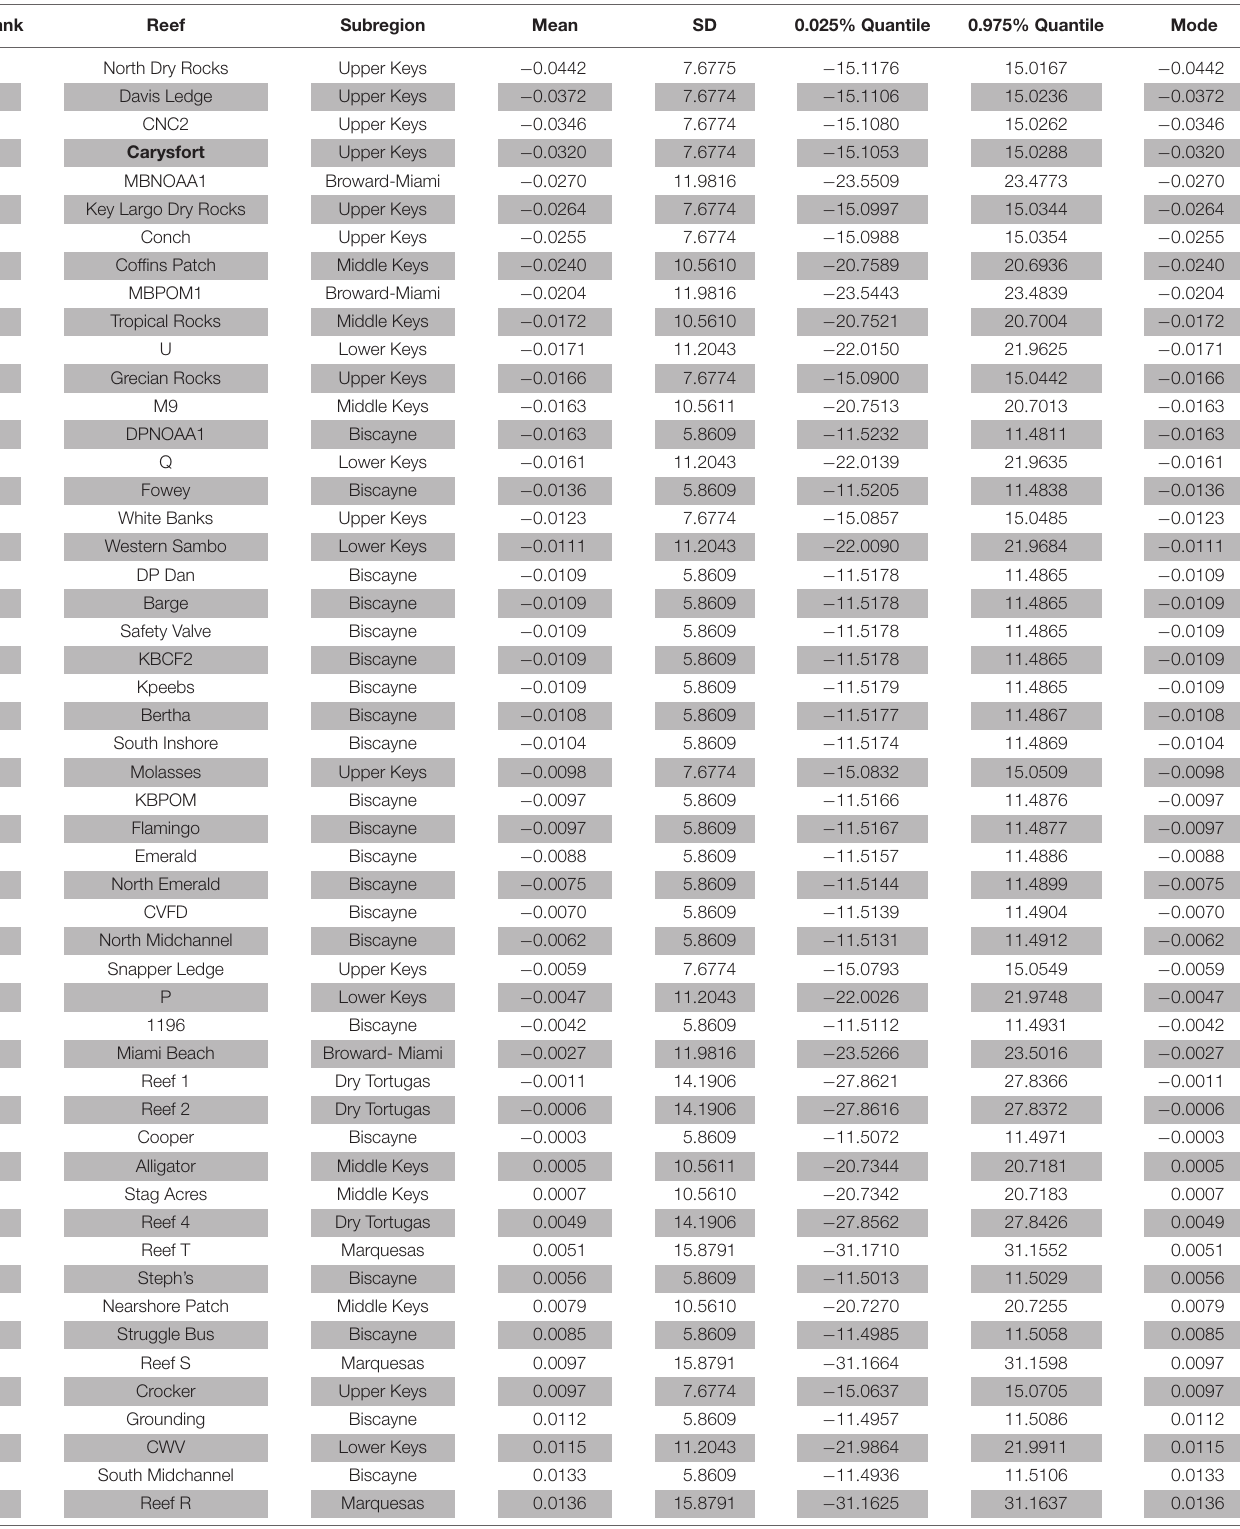
TABLE 1 | Posteriori mean (Mean); standard deviation (SD); 0.025, and 0.975% Quantile values; and Mode of the posteriori mean values using 67 reefs as the fixed effect in the Integrated Nested Laplace Approximation (INLA) model for 22,634 Acropora cervicornis outplants in 7 subregions along the Florida reef tract, United States from 2012 to 2018. The 7 subregions (from north east to south west) include: 1) Broward-Miami, 2) Biscayne, 3) Upper Keys, 4) Middle Keys, 5) Lower Keys, 6) Marquesas, and 7) Dry Tortugas. The reefs are listed from highest to lowest likelihood of survival of A. cervicornis outplants. Carysfort Reef, ranked # 4 and marked in bold, is included in the “Iconic Reefs”